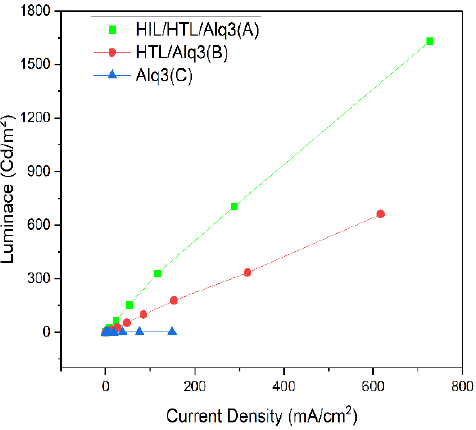
Figure 5. The curves of luminance and current density characteristics with linear–linear scale.